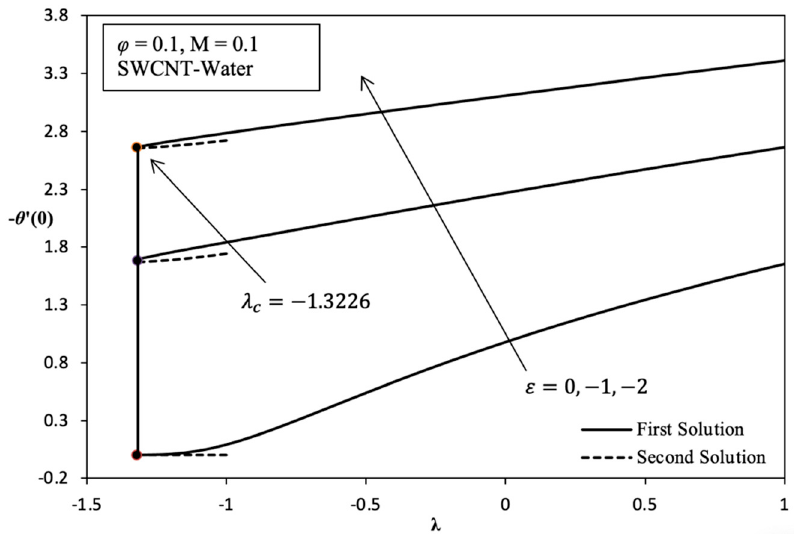
Figure 4. Variation of − 𝜃 ′ (0) versus 𝜆 with various values of 𝜀 in SWCNT-water when 𝜑 = 0.1 and M = 0.1.